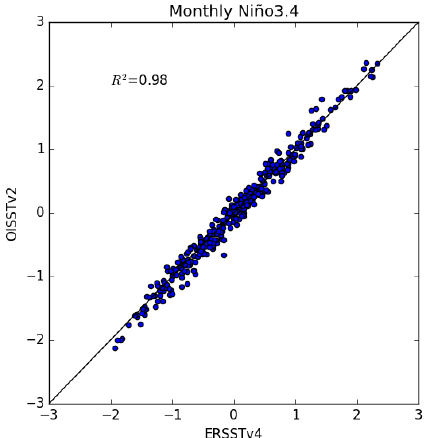
Figure 2. Scatter plot demonstrating the strong relationship be- tween monthly Niño3.4 anomalies calculated from monthly ERSST v4 data and daily OISST v2